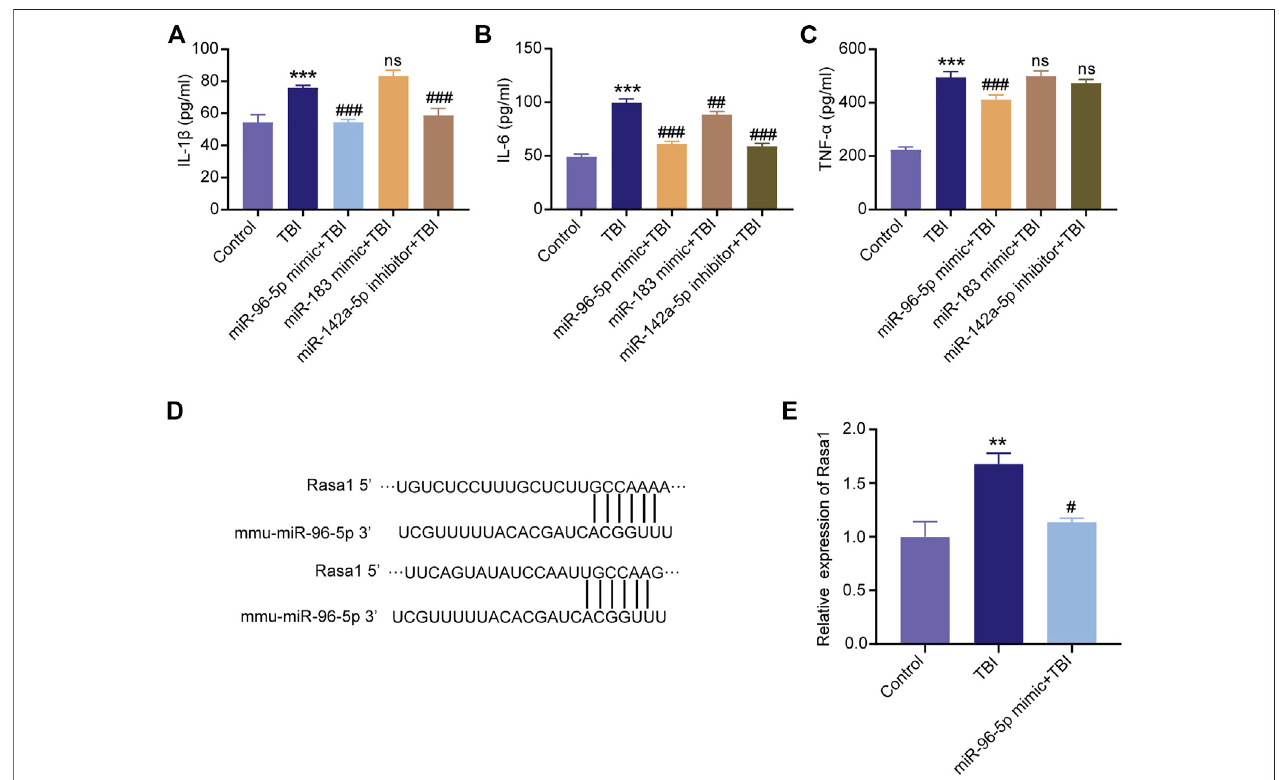
FIGURE 10 | Overexpression of miR-96-5p or miR-183-5p and inhibition of miR-142a-5p suppress the expression of in fl ammatory cytokines. ELISA was applied to detect the levels of IL-1 β (A) , IL-6 (B) , and TNF- α (C) inthe BV2 cells culture medium. (D) The binding region and seed sequence between miR-96-5p and Rasa1. (E) Validation of Rasa1 ’ s levels by qRT-PCR. miRNAs could silence the mRNAs, Rasa1 was signi fi cantly upregulated in scratch injury and downregulated in miR-96-5p mimic.Thedataareexhibitedasthemean±SD( n =3).*** p < 0.01,TBIgroupvs.controlgroup; ## p < 0.01and ### p < 0.001,miRNAsmimicorinhibitorgroupsvs. TBI